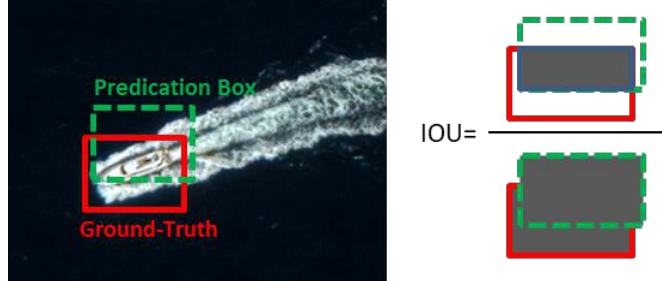
Figure 9. Intersection over the union (IOU) between the prediction box and the ground-truth box.